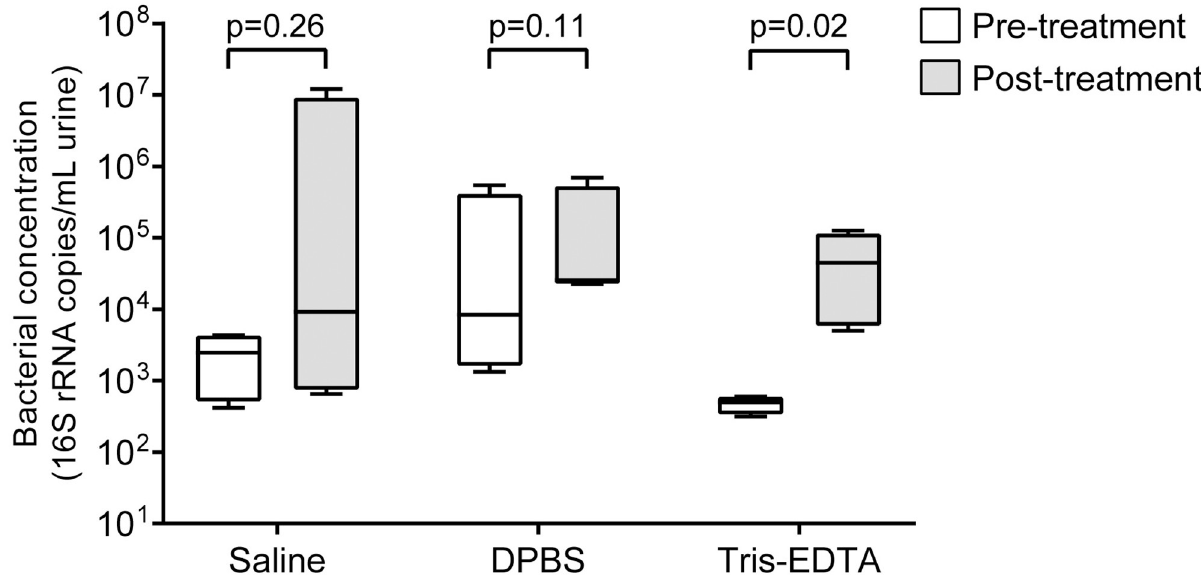
Fig 2. Bacterial DNA concentrations in urine samples before and after treatment with saline, DPBS, or Tris-EDTA. Data shown as box and whisker plots with whiskers representing maximum and minimum values (16S rRNA gene copies/mL of urine). Lines within each box represent median values. Mean bacterial concentrations in post-treatment samples treated with Tris-EDTA were found to be significantly